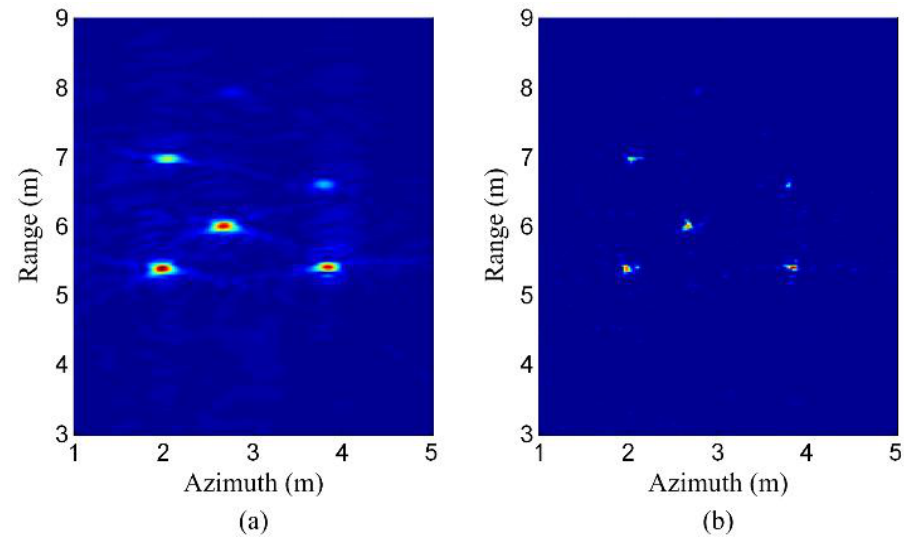
Figure 6. ( a ) Backprojection result of full data (81 azimuth measurements × 2001 frequencies). ( b ) CS result of under-sampled data (27 azimuth measurements × 128 frequencies).